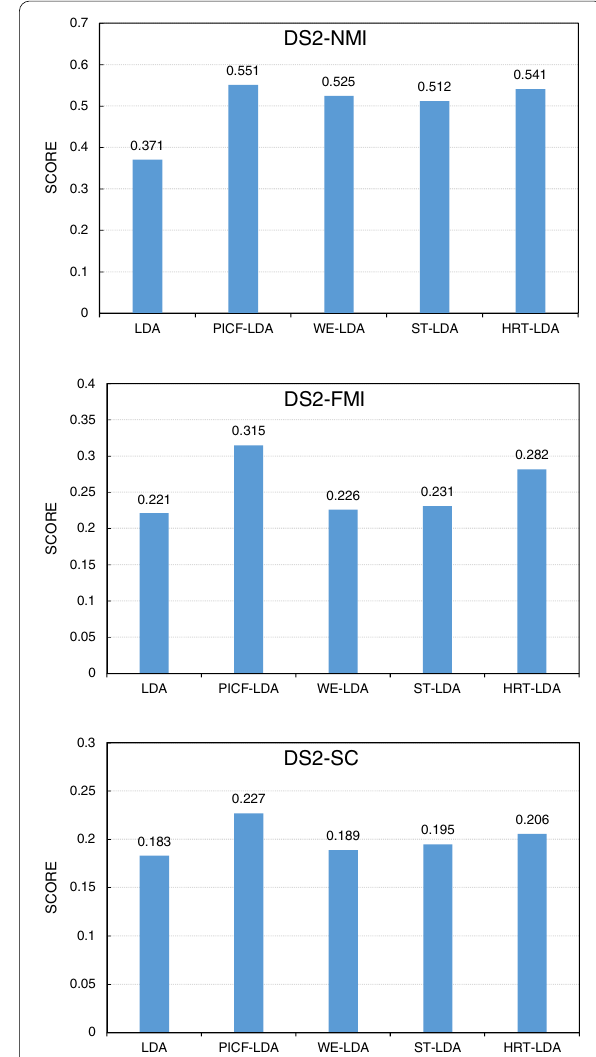
Fig. 6 Performance comparison between PICF-LDA and variant LDA models in